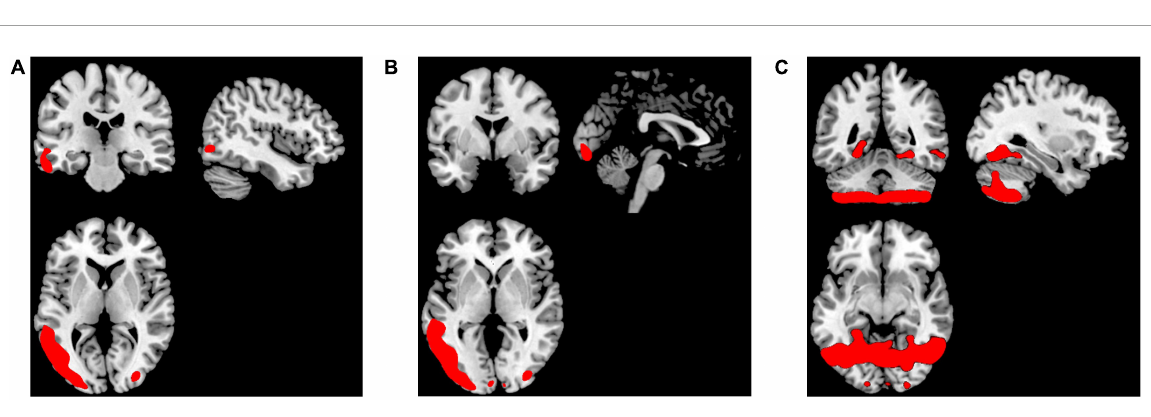
FIGURE2 Representation of the smoothed mean lambda map of the top-weighted distances in red for (A) FEP, (B) CHR, and (C) HC.